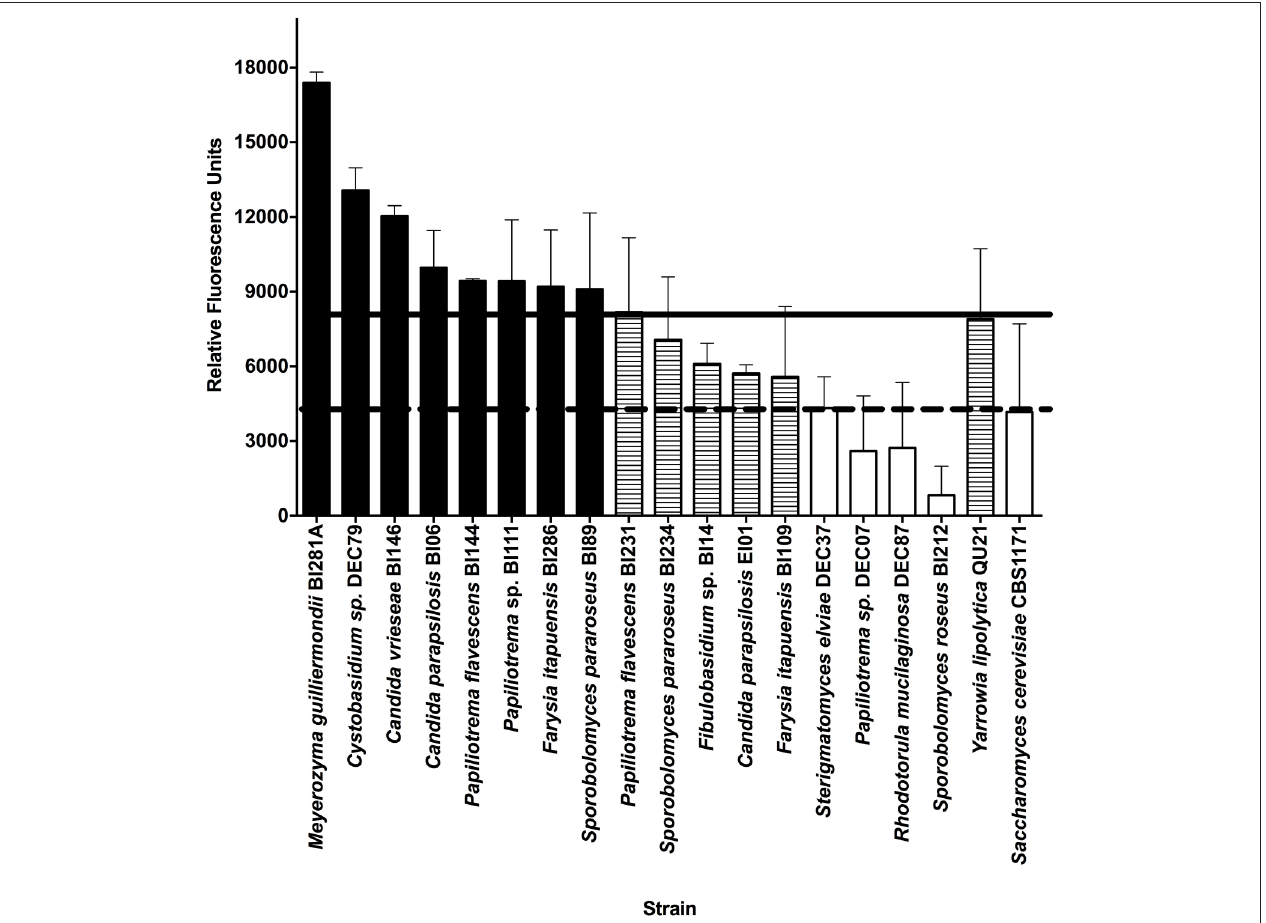
FIGURE 1 | Fluorescence intensity of yeast strains grown in medium A using Nile Red dye (50mg mL − 1 ). Absorption and Emission wavelengths were 488 and 585 nm, respectively. The horizontal solid line indicates the average Relative Fluorescence Units (RFU) of the positive control ( Y. lipolytica QU21) and the horizontal dotted line indicates the average RFU of the negative control ( S. cerevisiae CBS 1171). Strains with RFU above the positive control are black-filled, strains between positive control and negative control are pattern-filled and strains with RFU below the negative control are not filled. Strains without fluorescence emission were not included in the figure. All experiments were done in biological and technical